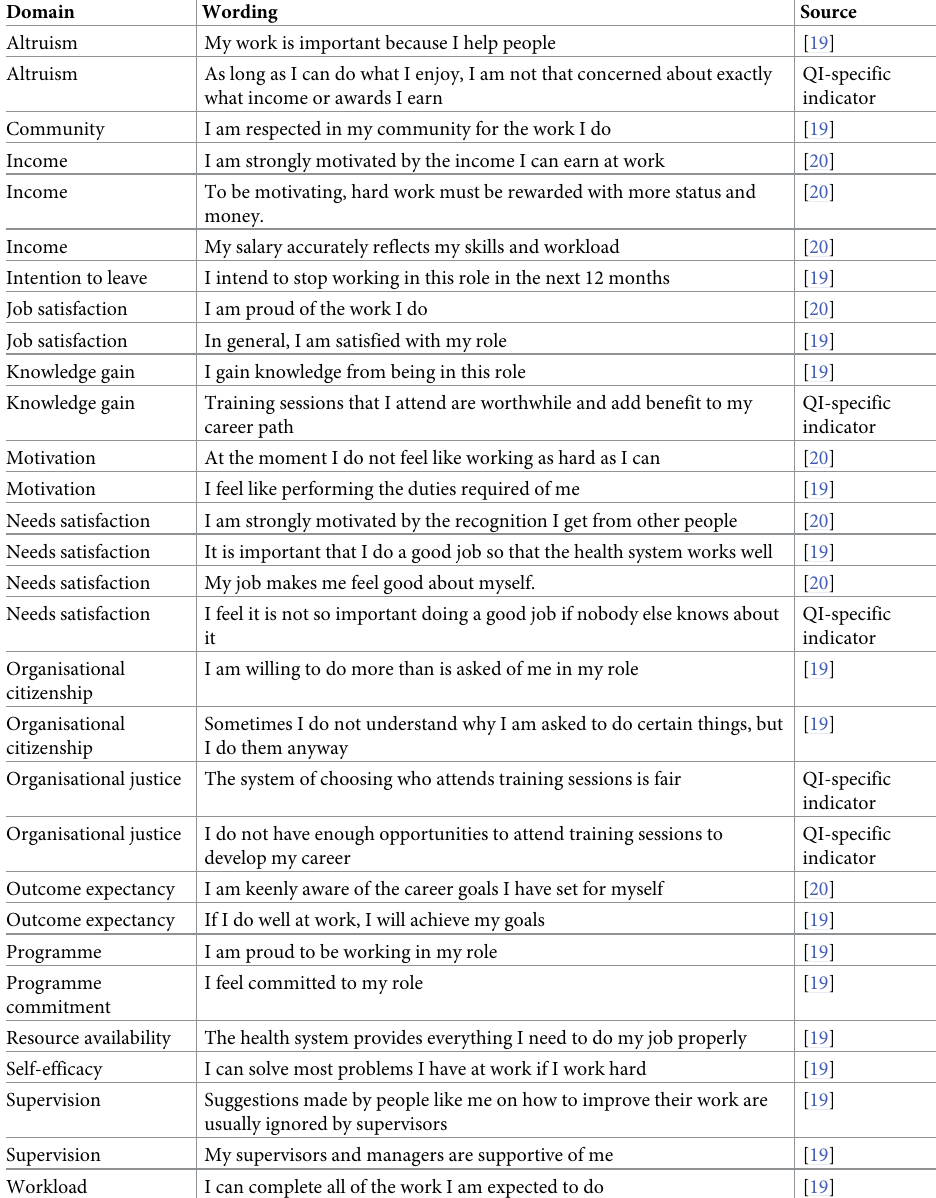
Table 1. Motivation questions included in survey, source, and domain from April 15–May 10,